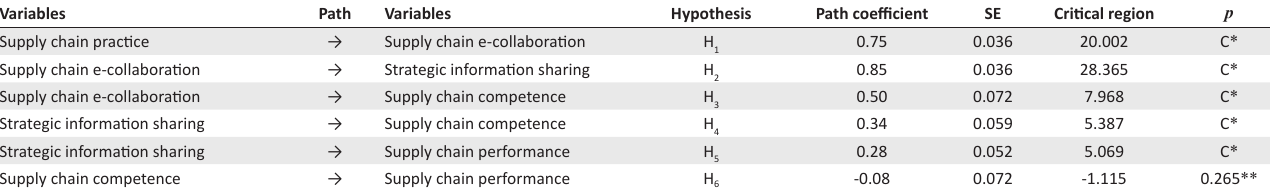
TABLE 6: Summary of structural equation modelling hypotheses results. Variables